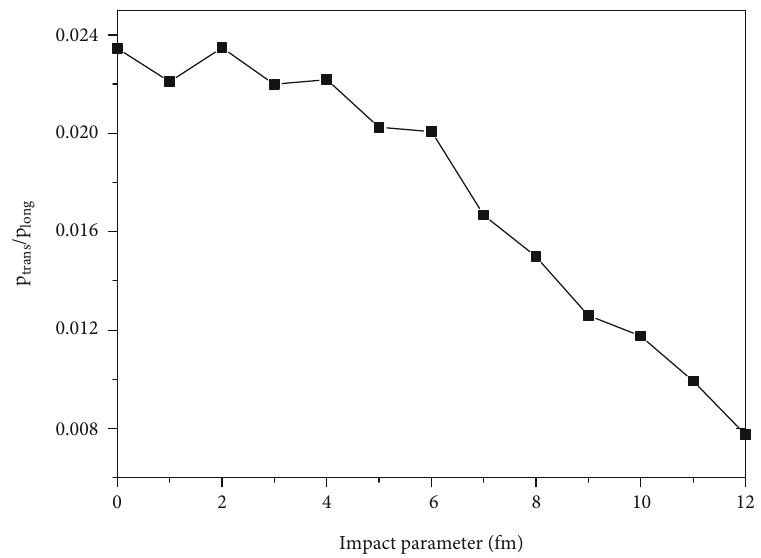
Figure 3: Correlation between the ratio of p